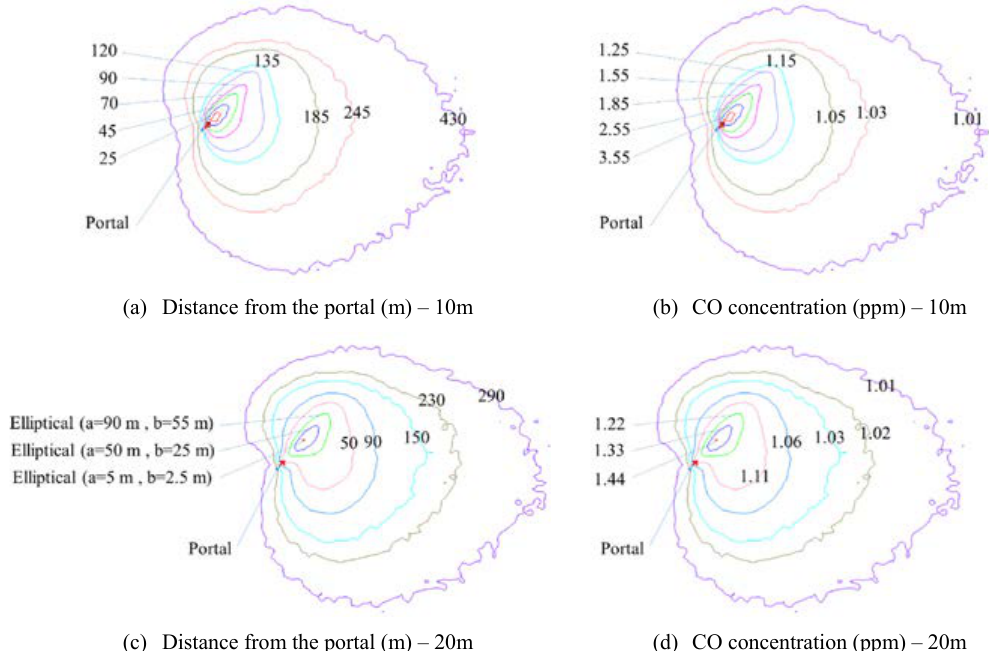
Fig. 9: Mean CO concentration at the eastern portal of the southern tunnel of the Niayesh tunnel for short-time dispersion modeling (with detail of values and distances)